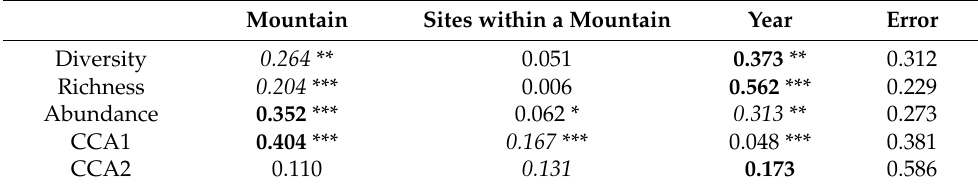
Table 3. Variation partitioning of carabid community composition among explanatory variables. Mountain Sites within a Mountain Year Error Diversity 0.264 ** 0.051 0.373 ** 0.312 Richness 0.204 *** 0.006 0.562 *** 0.229 Abundance 0.352 *** 0.062 * 0.313 ** 0.273 CCA1 0.404 *** 0.167 *** 0.048 *** 0.381